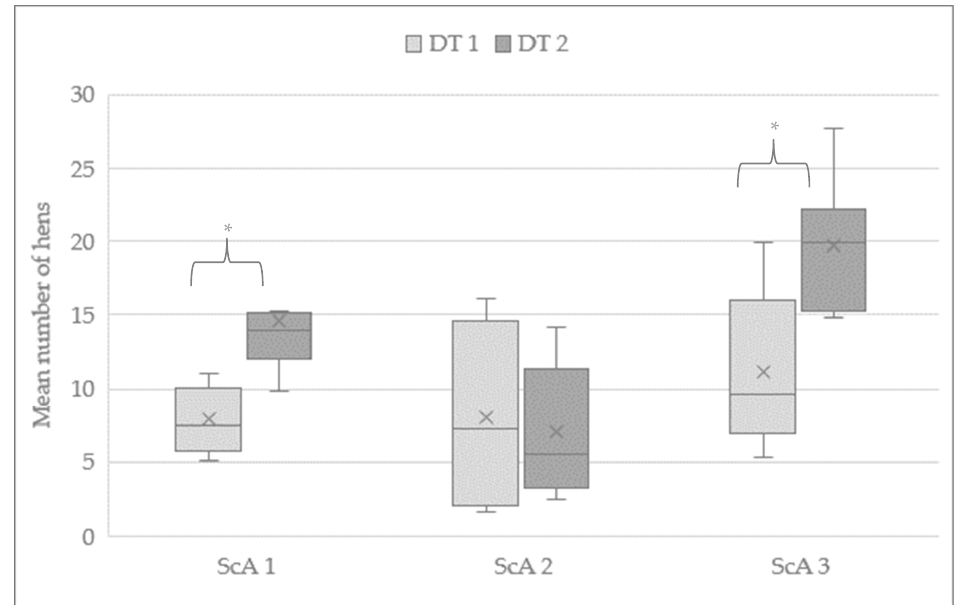
Figure 2. Mean number of hens in three different observation areas (ScA 1 and 3 with the enrichment device, and ScA 2 without the enrichment device) for different times of the day (DT 1: hours before maize supply (10:00 to 13:50); DT 2: hours during supply (13:51 to 20:00)). An asterisk indicates significant differences ( p < 0.05). Boxplots indicate the data range, median, lower, and upper quartiles and mean value.